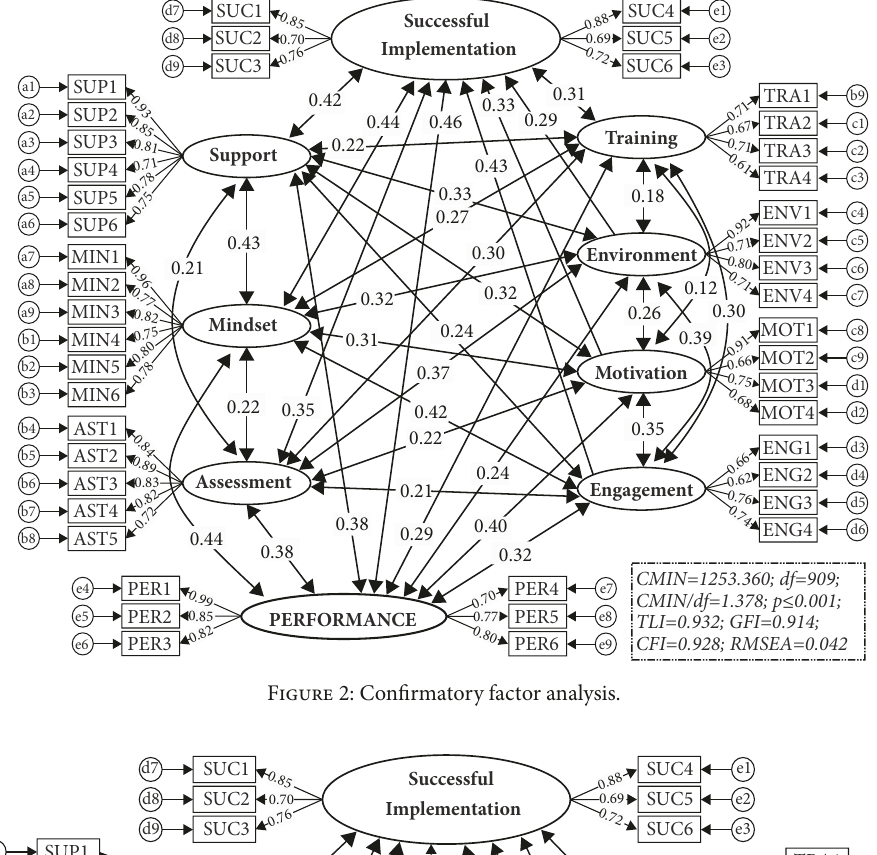
Figure 2: Confirmatory factor analysis.